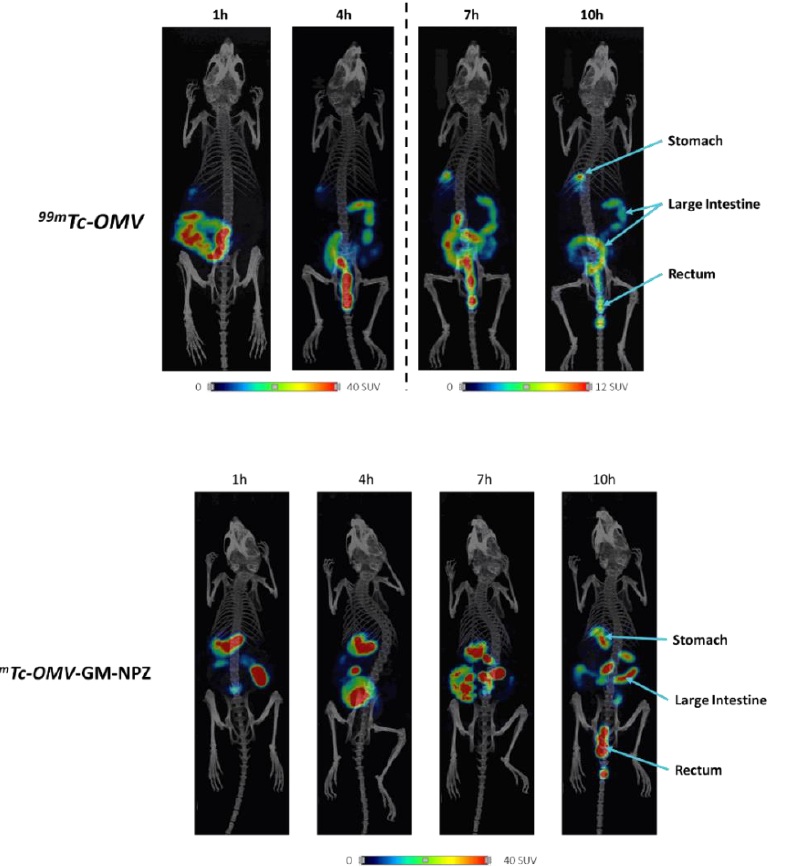
Figure 4. Biodistribution of radiolabeled outer membrane vesicles (OMV) or OMV encapsulated into zein nanoparticles coated with Gantrez ® (GM-NPZ) after oral administration in BALB/c mice. Location of the radiolabeled samples was obtained after 1, 4, 7 or 10 h using a microSPECT/CT model U-SPECT6/E-class (MILabs) apparatus. Samples were labeled with 99mTc and the intensity of the signal was expressed in Standardized Uptake Value (SUV). Blue arrows indicate organs where the signal was detected.